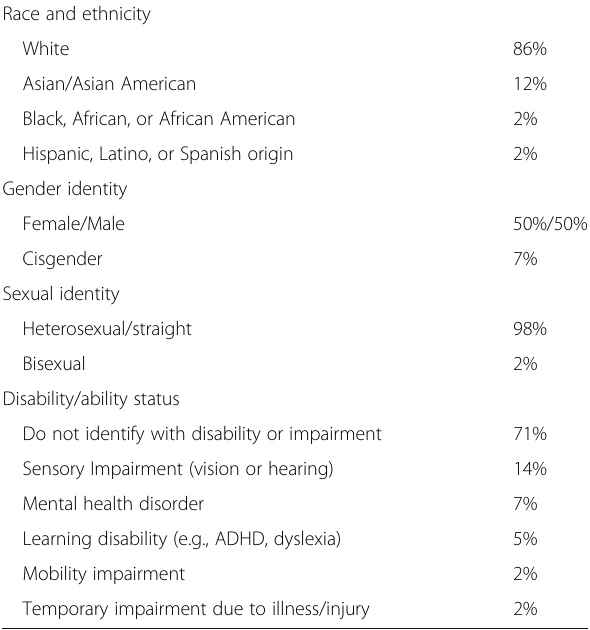
Table 3 Demographics of faculty participants Race and